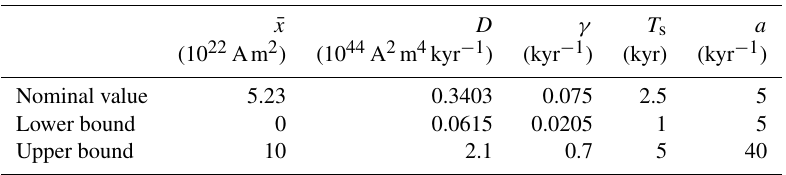
Table 3. Nominal parameter values and parameter